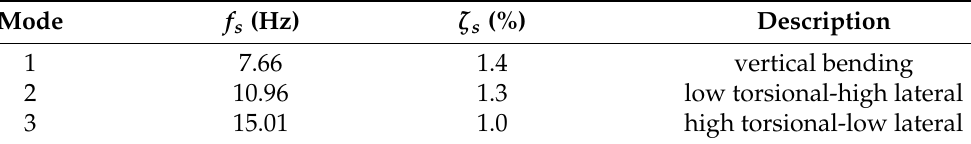
Table 1. Experimental first three vibration modes of the FRP footbridge.